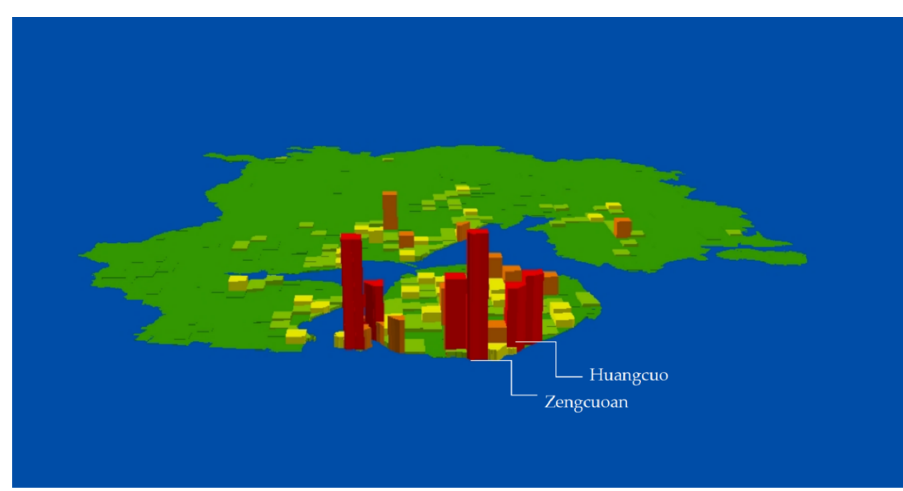
Figure 3. Spatial distribution of hotel density in Xiamen. (Source: drawn by the authors).